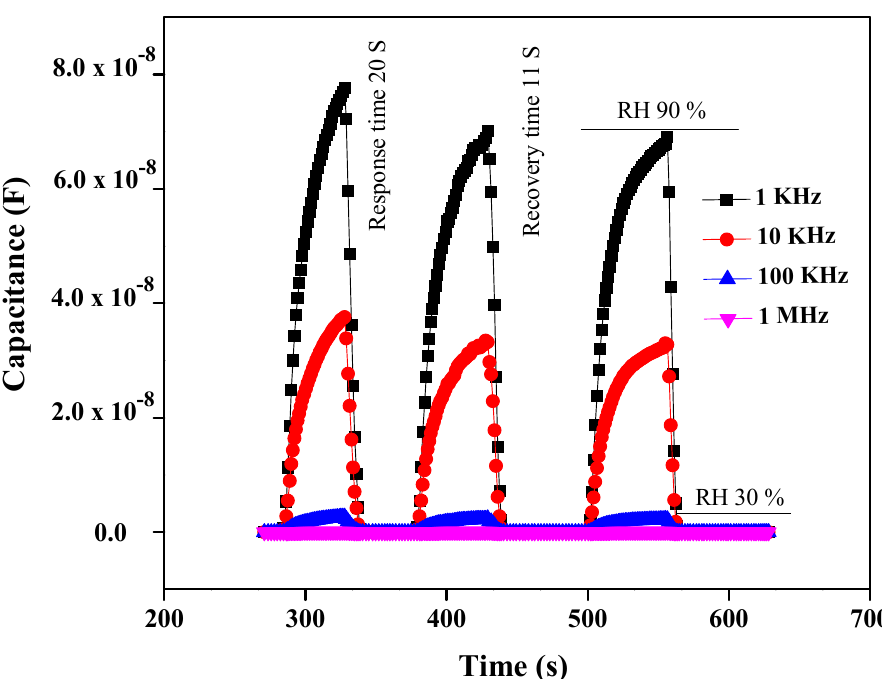
Figure 10. Capacitance response/recovery time for PEO − MWCNT − CuO: 3% nanocomposites.